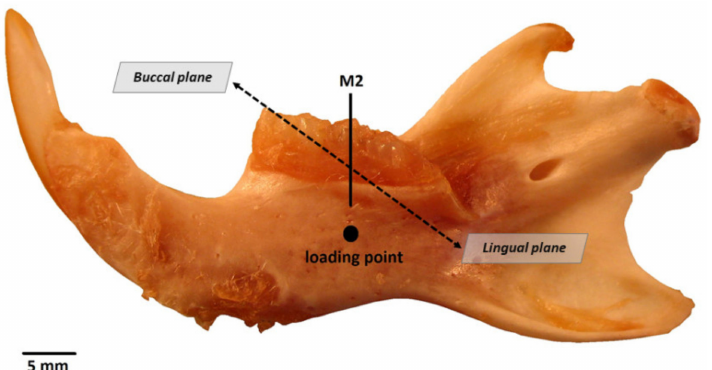
Figure 1. Mandible from a Wistar rat, control group specimen. M2, 2nd molar; loading point for the three-point bending test. Buccal and lingual planes are shown for